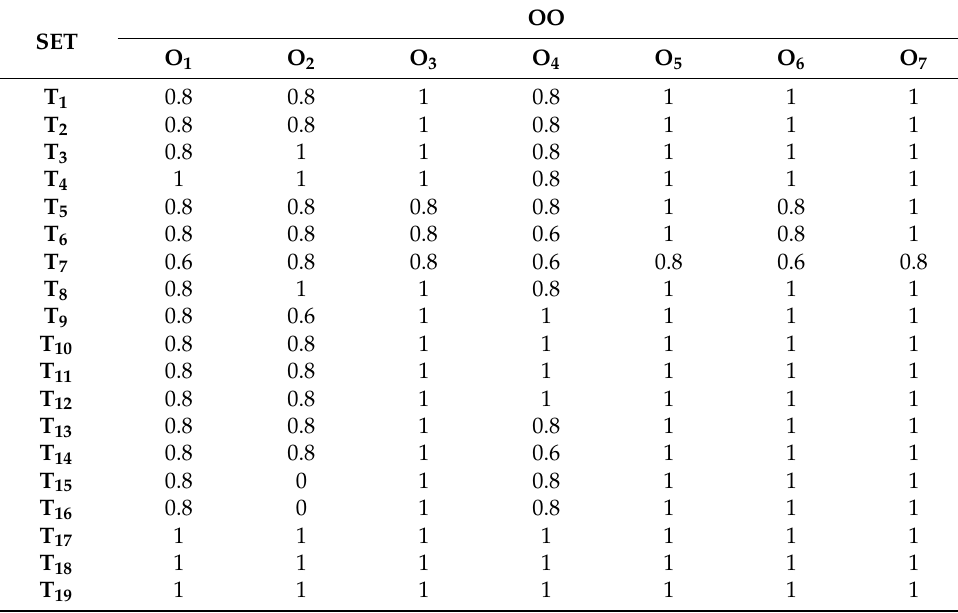
Table 7. Max-min composition Fuzzy relation matrices—SETs to OOs.